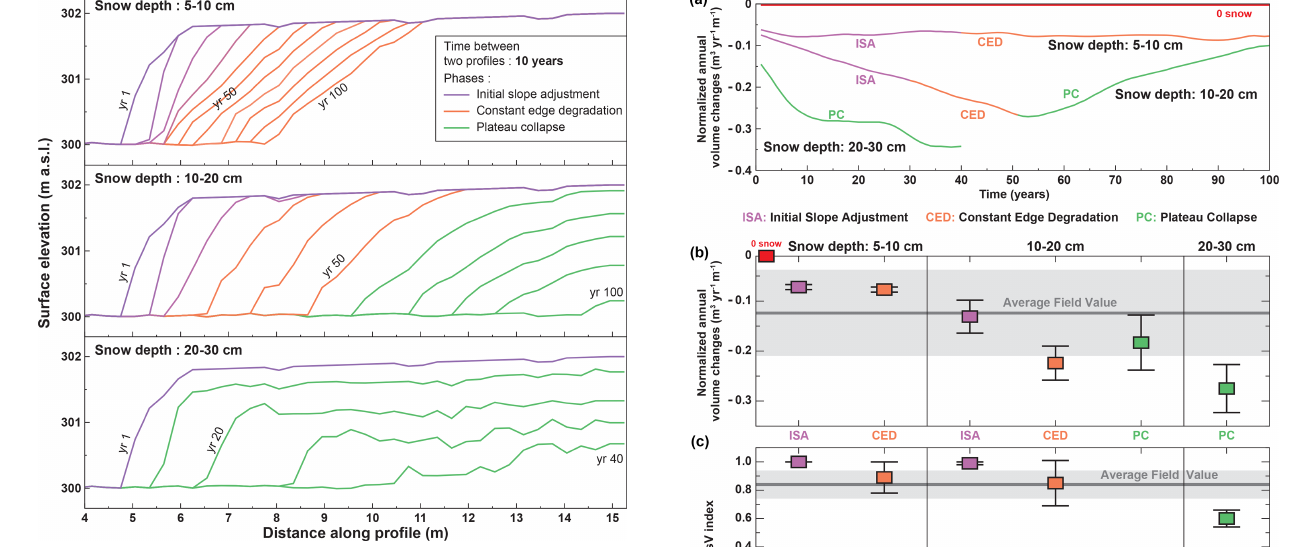
Figure 8. Surface elevation profiles of the peat plateaus as simu- lated with CryoGrid3 for different snow depths on top of the plateau in time increments of 10 years. Three phases are identified (see text): initial slope adjustment (slope modifications along time), con- stant edge degradation (slope conserved) and plateau collapse (sub- sidence over the full plateau). Note that the /textit0cm snow simu- lation (not shown) did not produce any changes to the initial topog- raphy.